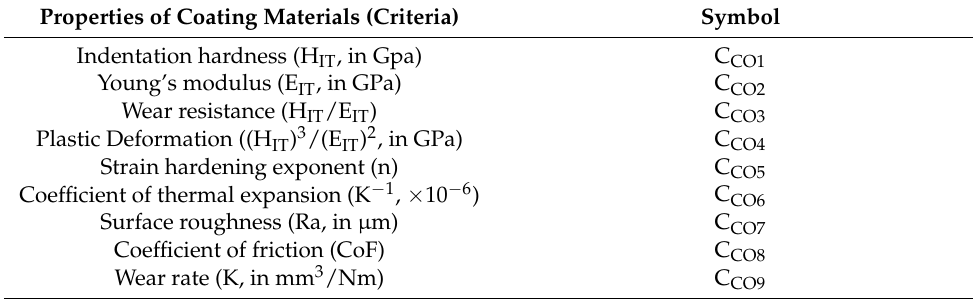
Table 2. Selection criteria of coating material.